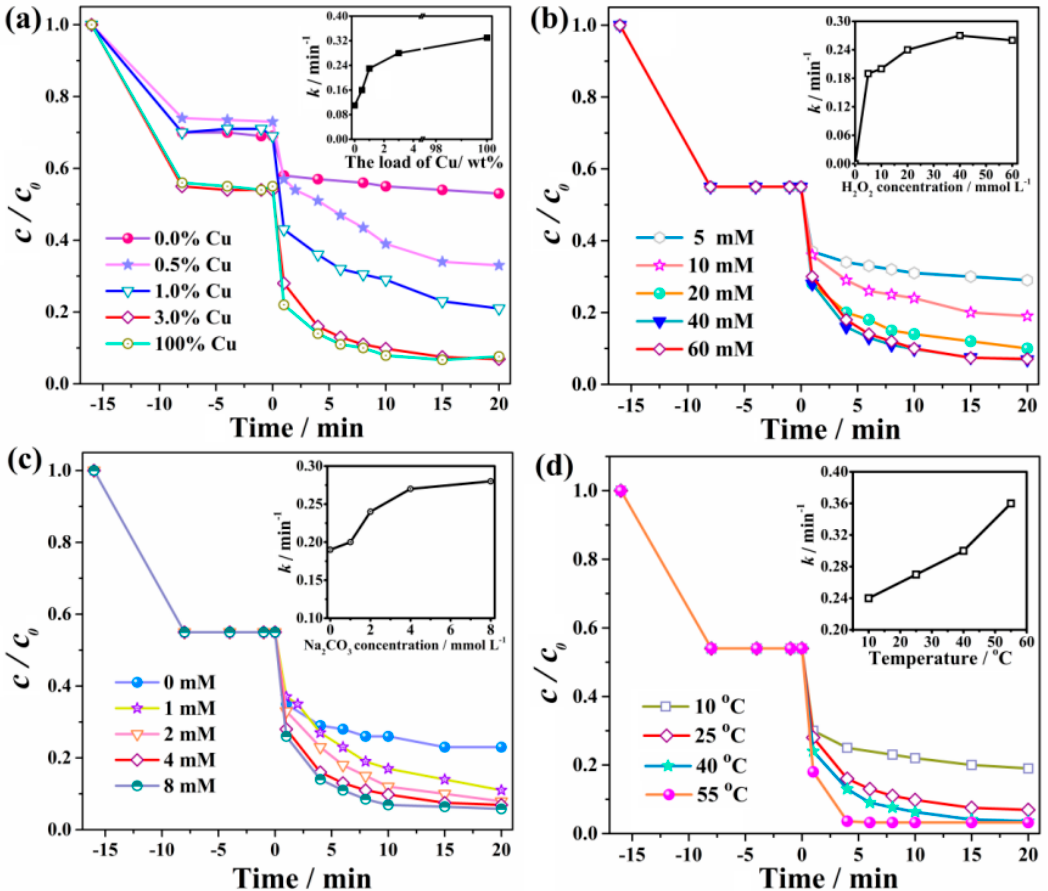
Figure 5. Effects of different reaction parameters on the adsorption and degradation of RhB over Cu / N-rGO: ( a ) Cu load, ( b ) H 2 O 2 concentration, ( c ) Na 2 CO 3 concentration, and ( d ) temperature. The insets give the dependence of the apparent rate constant of RhB degradation on the specified reaction parameter.